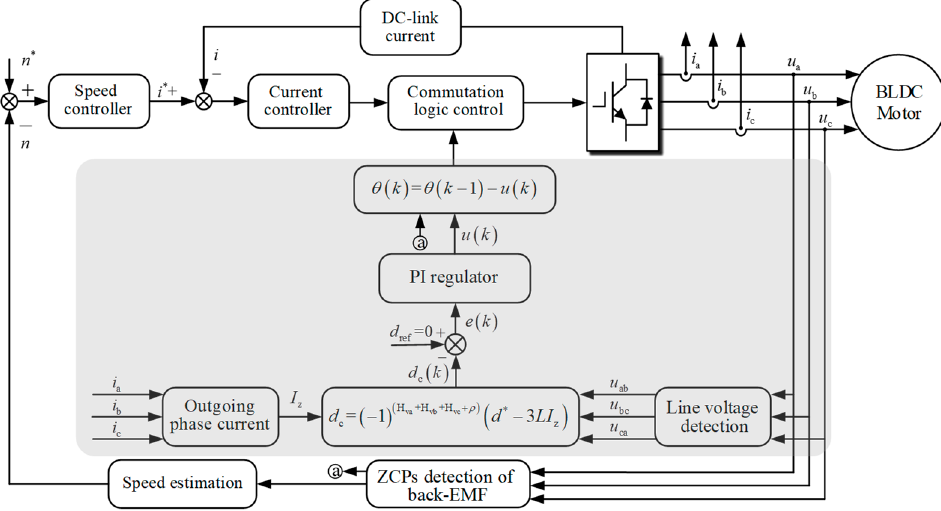
Figure 8. Sensorless BLDC motor drive system with the proposed strategy.